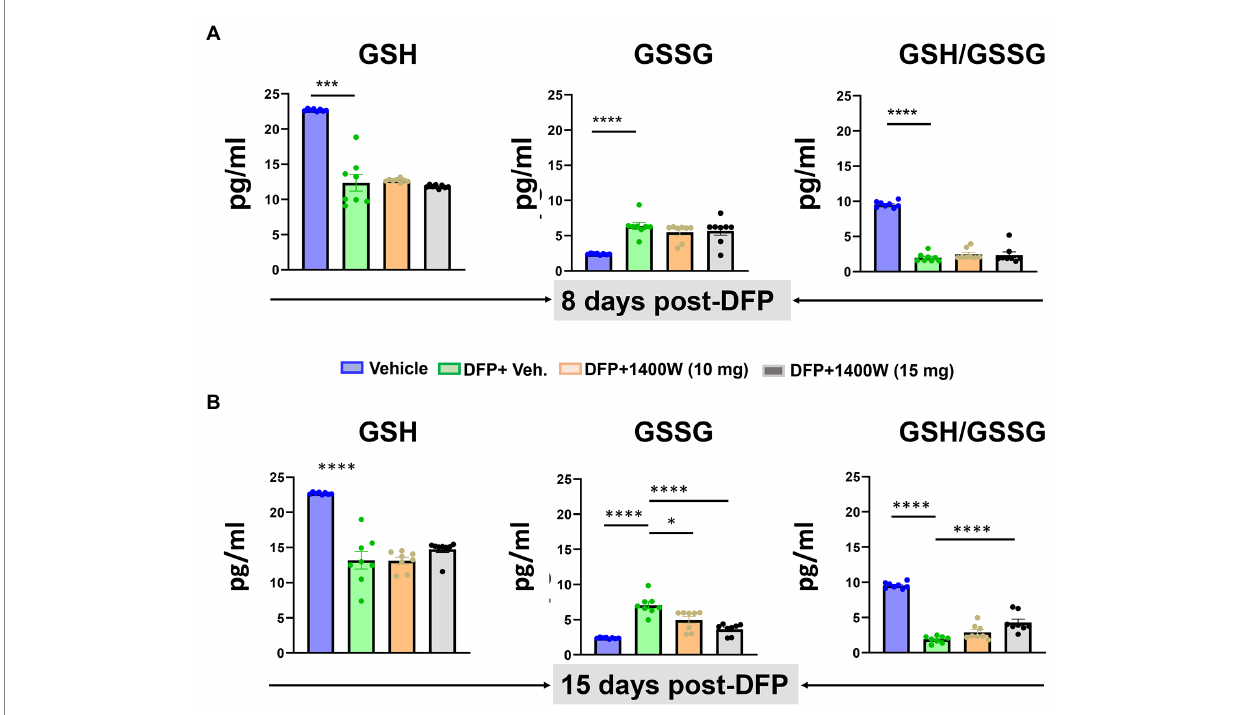
FIGURE 8 The effects of DFP and 1400W on serum glutathione profiles. At 8-day, 1400W (10 mg/kg or 15 mg/kg) had no significant effect on serum GSH and GSSG levels (A) . At 15-day post DFP, 1400 W (15 mg/kg) significantly reduced GSSG levels and also increased the GSH/GSSG ratio in DFP exposed rats (B) , n = 8, one-way ANOVA with Tukey’s post-hoc for multiple comparisons; * p < 0.05, ** p < 0.01, *** p < 0.001.